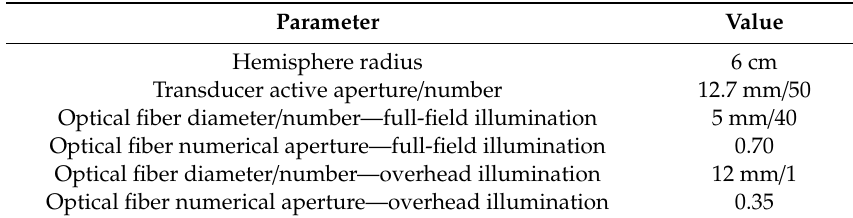
Table 2. 3D HA-PACT System